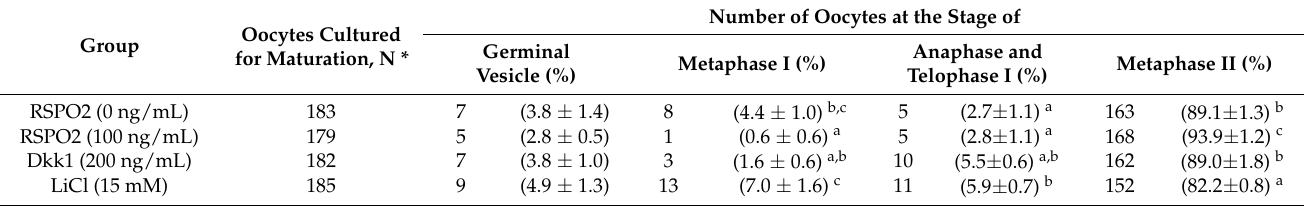
Table 4. Effect of R-spondin2 (RSPO2), WNT inhibitor, or activator treatment during IVM on nuclear maturation. Number of Oocytes at the Stage of Oocytes Cultured Group Anaphase and Germinal for Maturation, N * Metaphase I (%) Telophase I Vesicle (%)